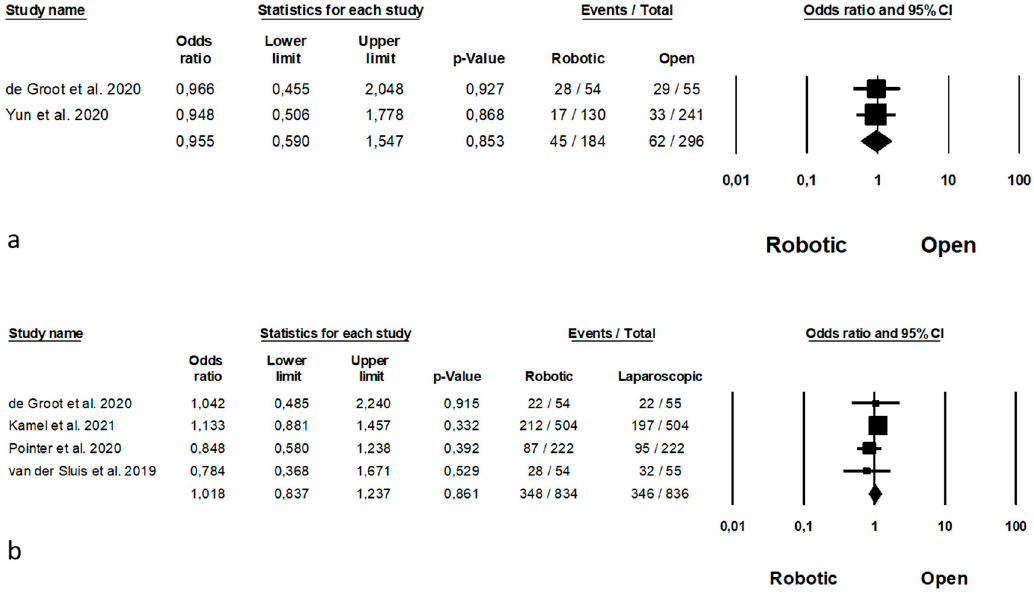
Figure 11. Robotic versus open surgery: long-term outcomes. ( a ) recurrences; ( b ) 5-years overall survival.